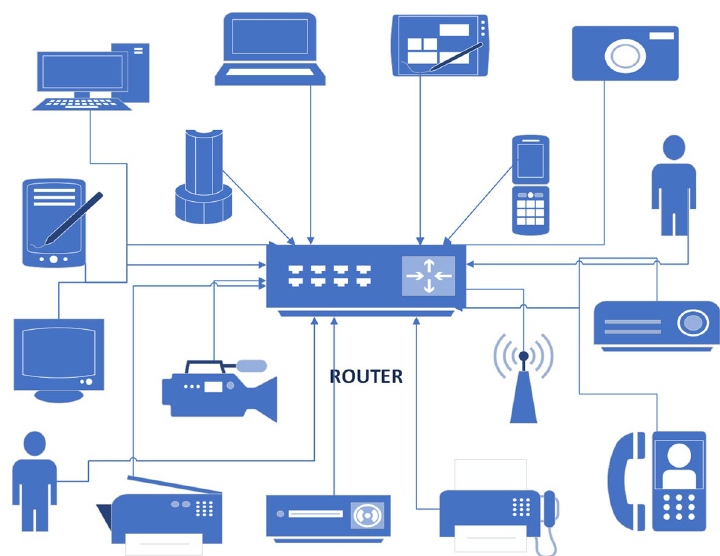
Fig. 7 Advanced smart home sensor and router communication